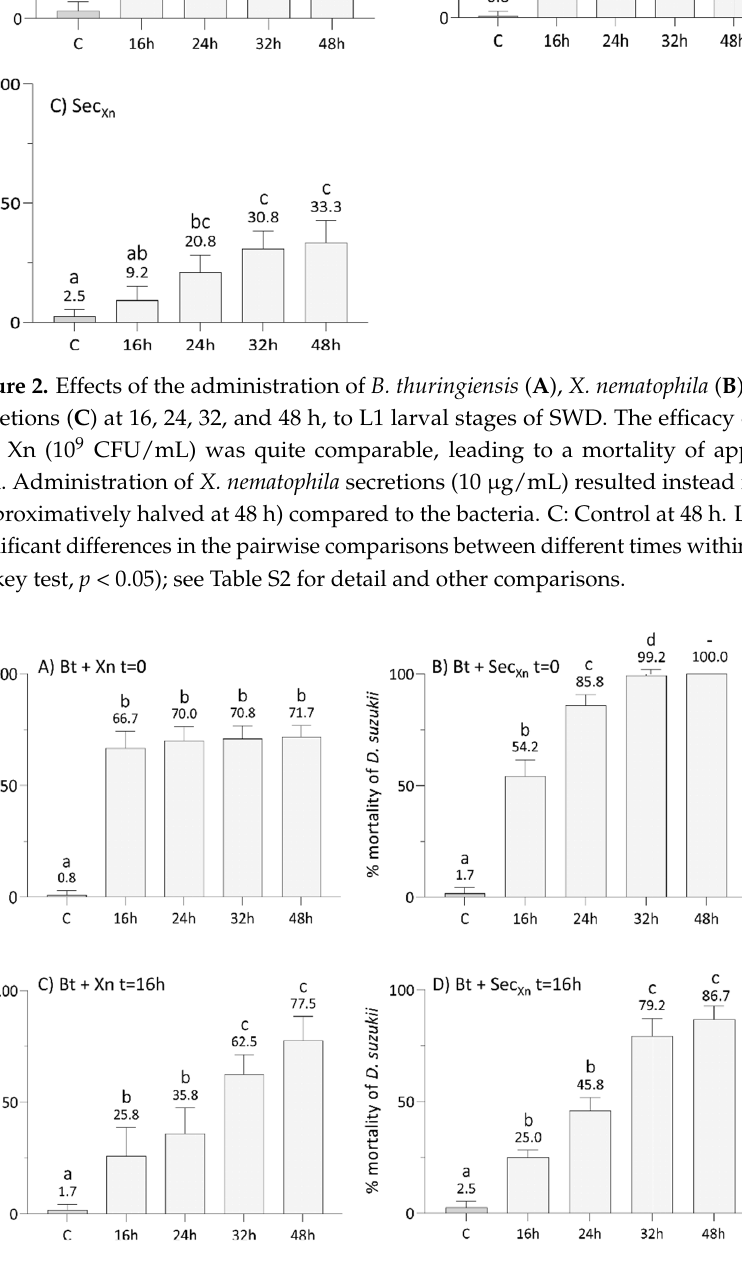
Figure 3. Lethal effects on SWD larvae of combined administration of B. thuringiensis plus X. nema- tophila (panels A and C ), or plus X. nematophila secretions (panels B and D ), either simultaneously ( A , C ), or plus X. nematophila secretions ( B , D ), either simultaneously at t = 0 ( A , B ) or with the second at t = 0 (panels a and b) or with the second treatment delayed by 16 h (panels c and d). All the assays treatment delayed by 16 h ( C , D ). All the assays with combined administration resulted in a higher and with combined administration resulted in a higher and faster mortality compared to the single treat- faster mortality compared to the single treatments (see Figure 2). Concurrent administrations were more ments (see Figure 2). Concurrent administrations were more effective than time-shifted administra- effective than time-shifted administration. C: control at 48 h. Letters (a–d) indicate significant differences tion. C: control at 48 h. Letters (a–d) indicate significant differences in the pairwise comparisons in the pairwise comparisons between different times within the same treatment (Tukey test, p < 0.05); between different times within the same treatment (Tukey test, p < 0.05); see Table S2 for detail and other comparisons. see Table S2 for detail and other